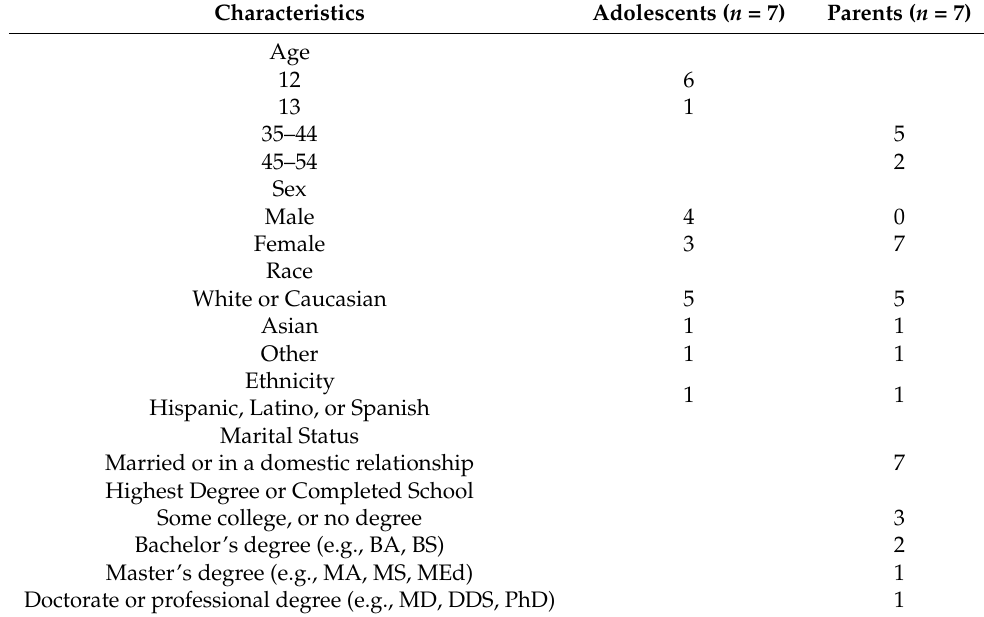
Table 3. Sociodemographic Characteristics of the Adolescent and Parent Participants.